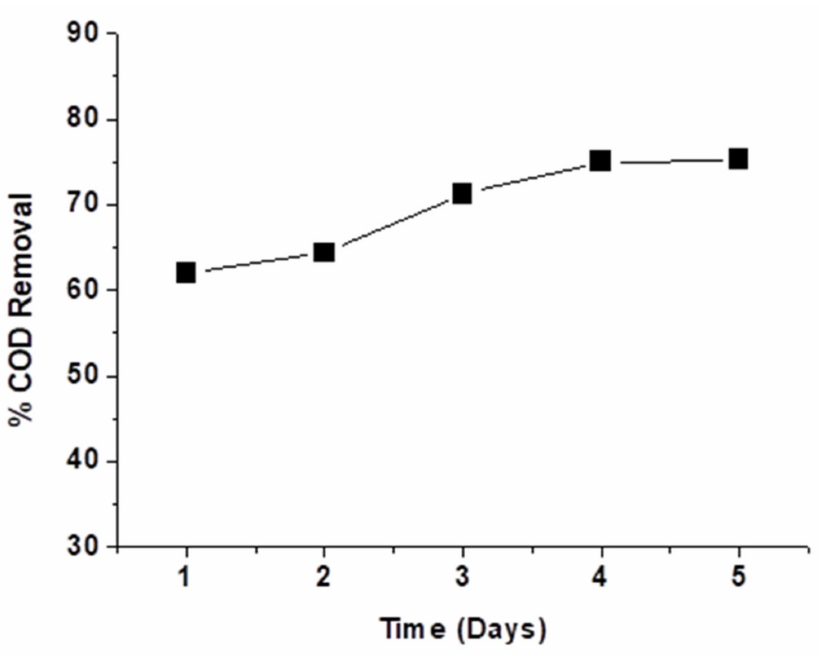
Figure 6. Effect of contact time in days on the % COD removal from PW by sheep dung ash as adsorbent (without shaking of the